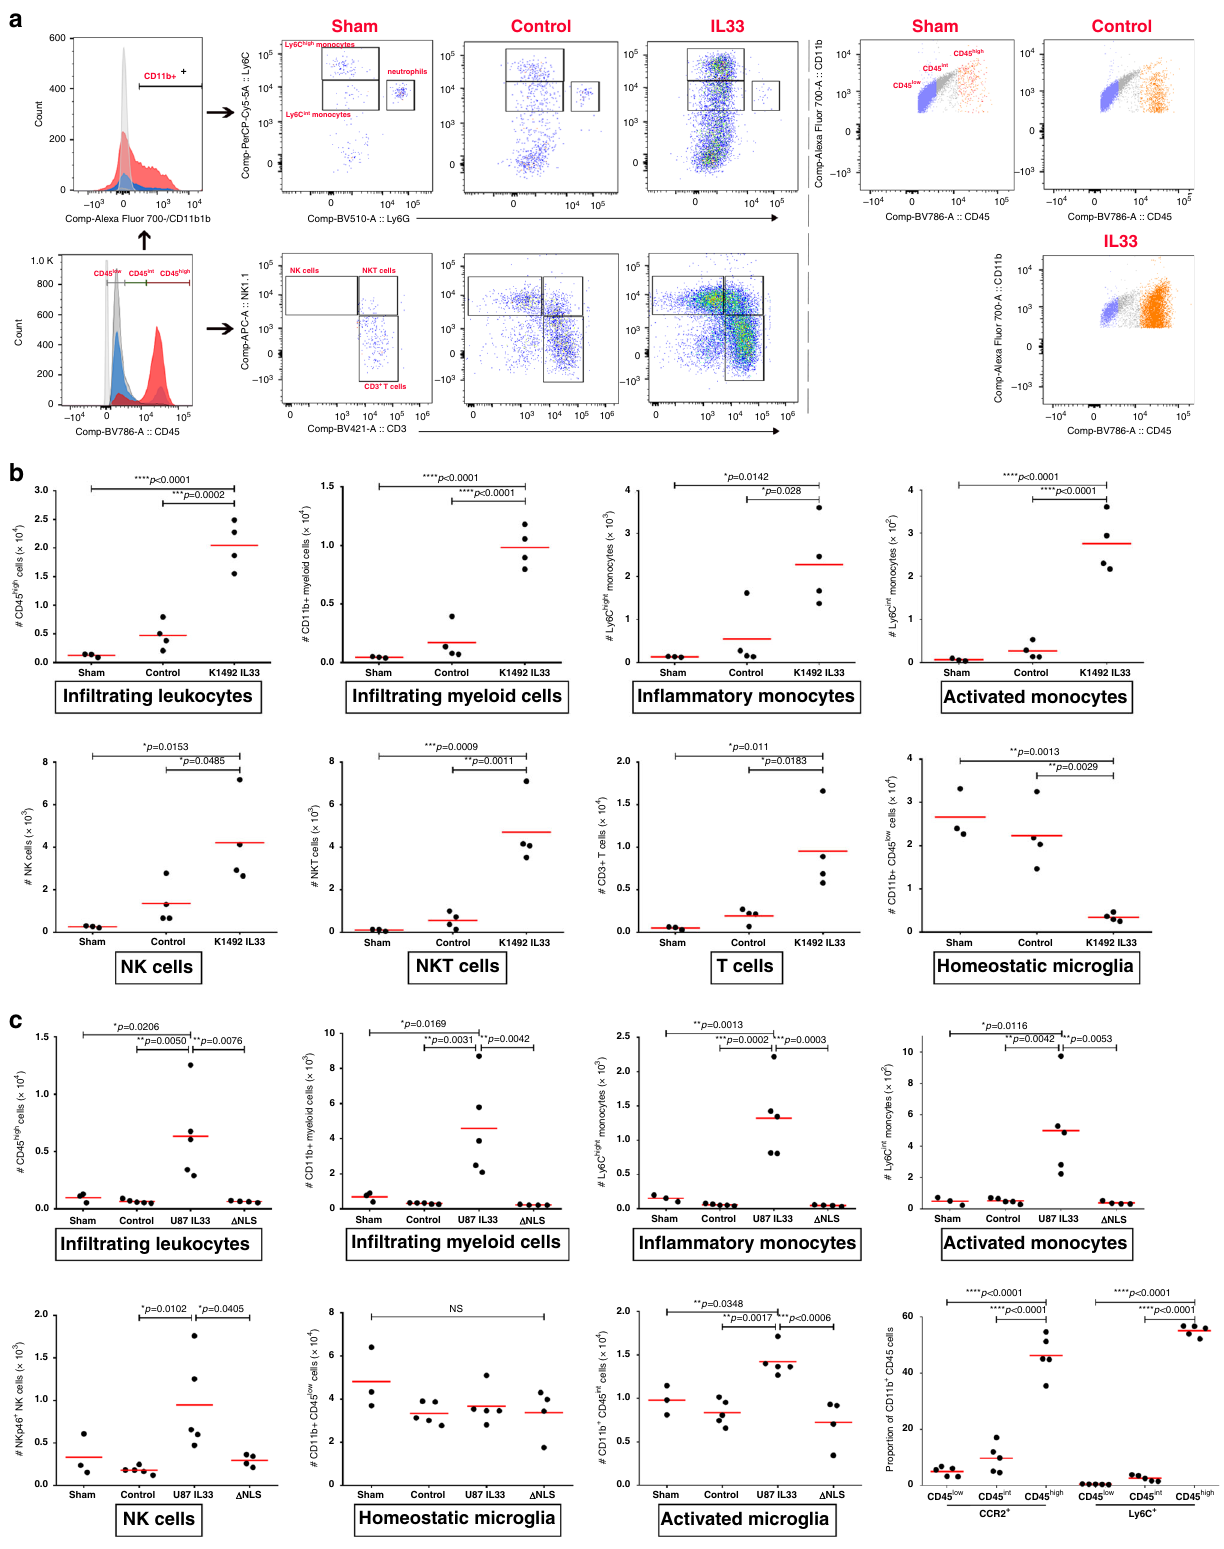
shown in Supplementary Fig. 7a. The total number of isolated CD45 + leukocytes was two-fold higher in IL-33 + vs. IL-33 − 1492 tumor-bearing mice. Using differential levels of CD45 to distin- guish between resident and in fi ltrating immune cells, we found a striking increase in the presence of CD45 high cells within the tumor-bearing hemisphere of IL-33 + vs. IL-33 − syngeneic